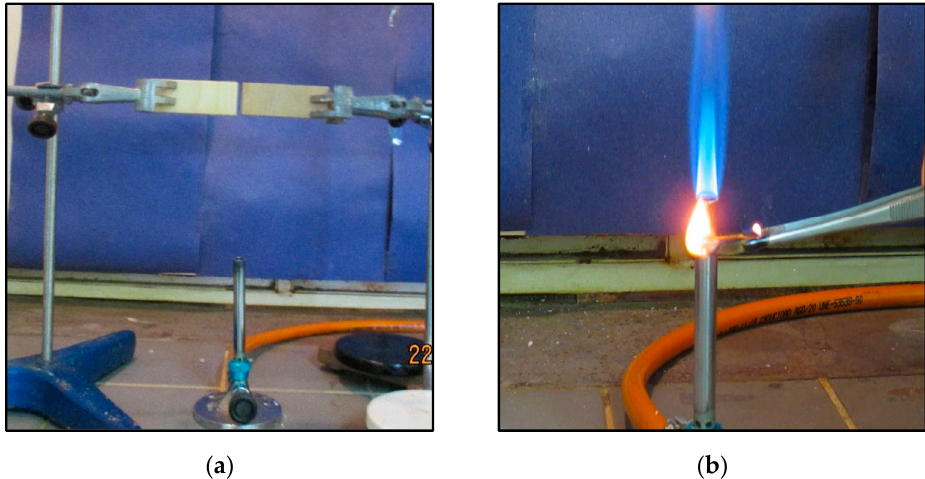
Figure 1. ( a ) Experimental set up for flame retardant test. ( b ) Running test of a single wooden mini-block.